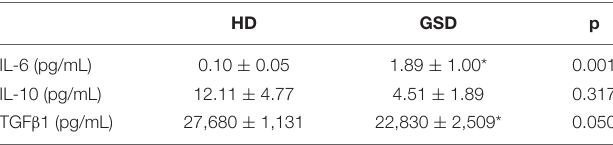
TABLE 2 | Serum cytokines involved in Treg regulation and